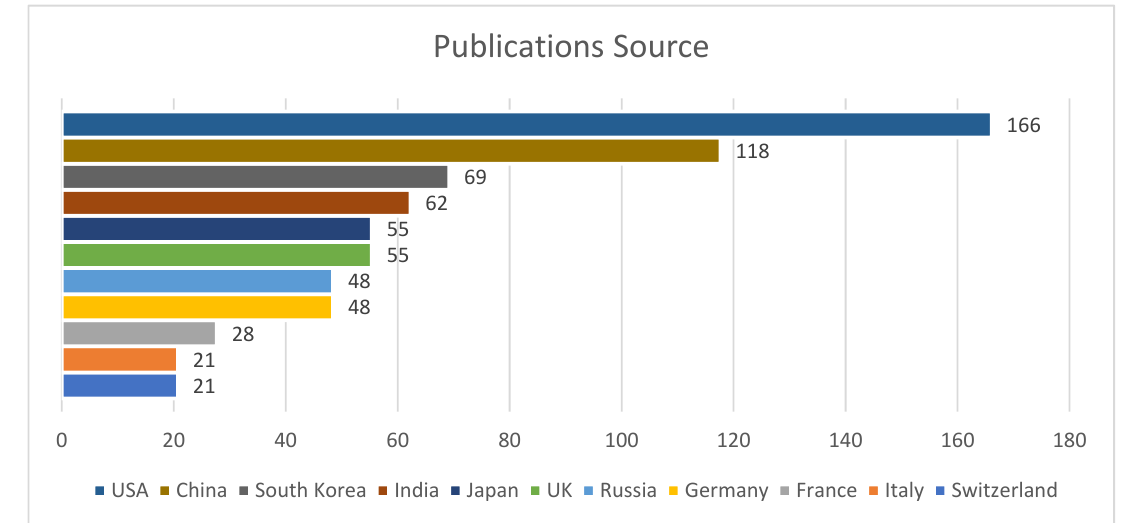
Figure 5. Publication Distribution by Country.